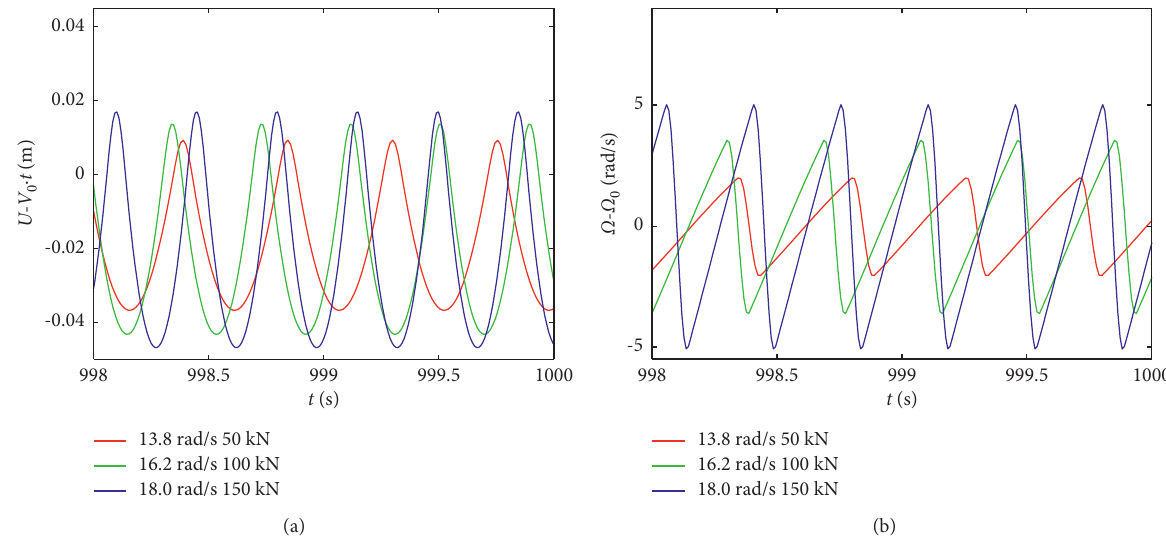
Figure 11: The time process of bit bounce phenomenon, k angular velocity of torsional vibration.